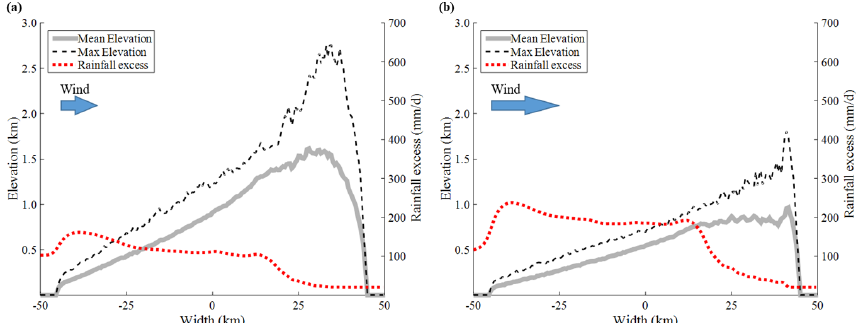
Figure 8. Transects of landscapes and rainfall fields from co-evolution simulations after 5Ma simulation times. Simulation settings are (a) V = 8ms − 1 , t d = 1200s and (b) V = 16ms − 1 , t d =